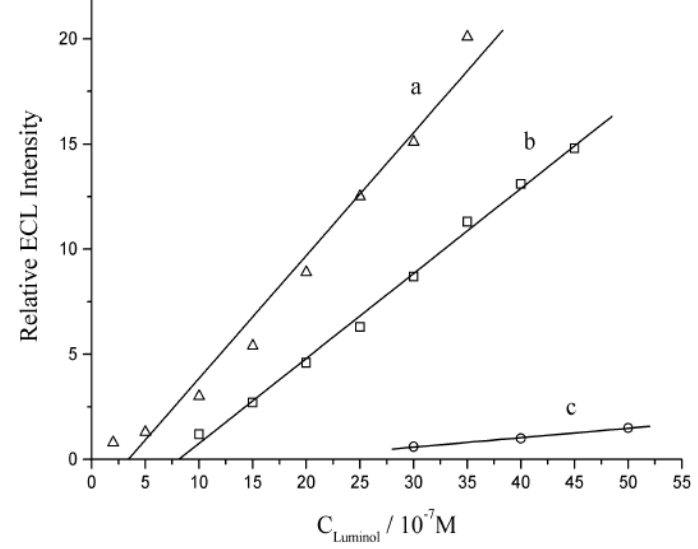
Figure 3. The ECL responses of luminol on (a) CNTs/AuNPs/GC electrode, (b) ssDNA modified and (c) dsDNA modified CNTs/AuNPs/GC